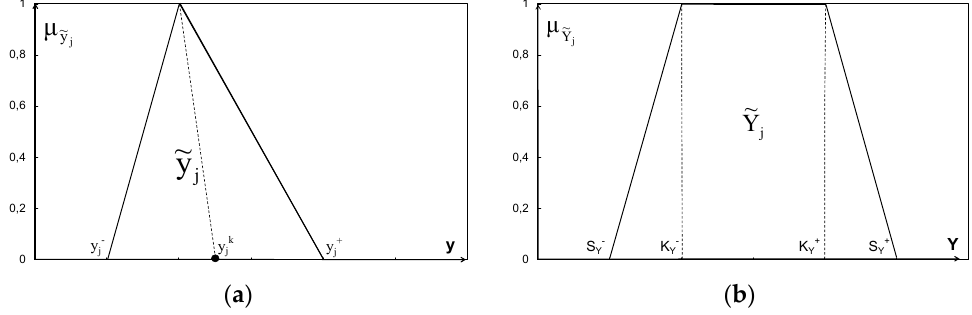
Figure 1. ( a ) Triangular membership function, ( b ) Trapezoidal membership function.